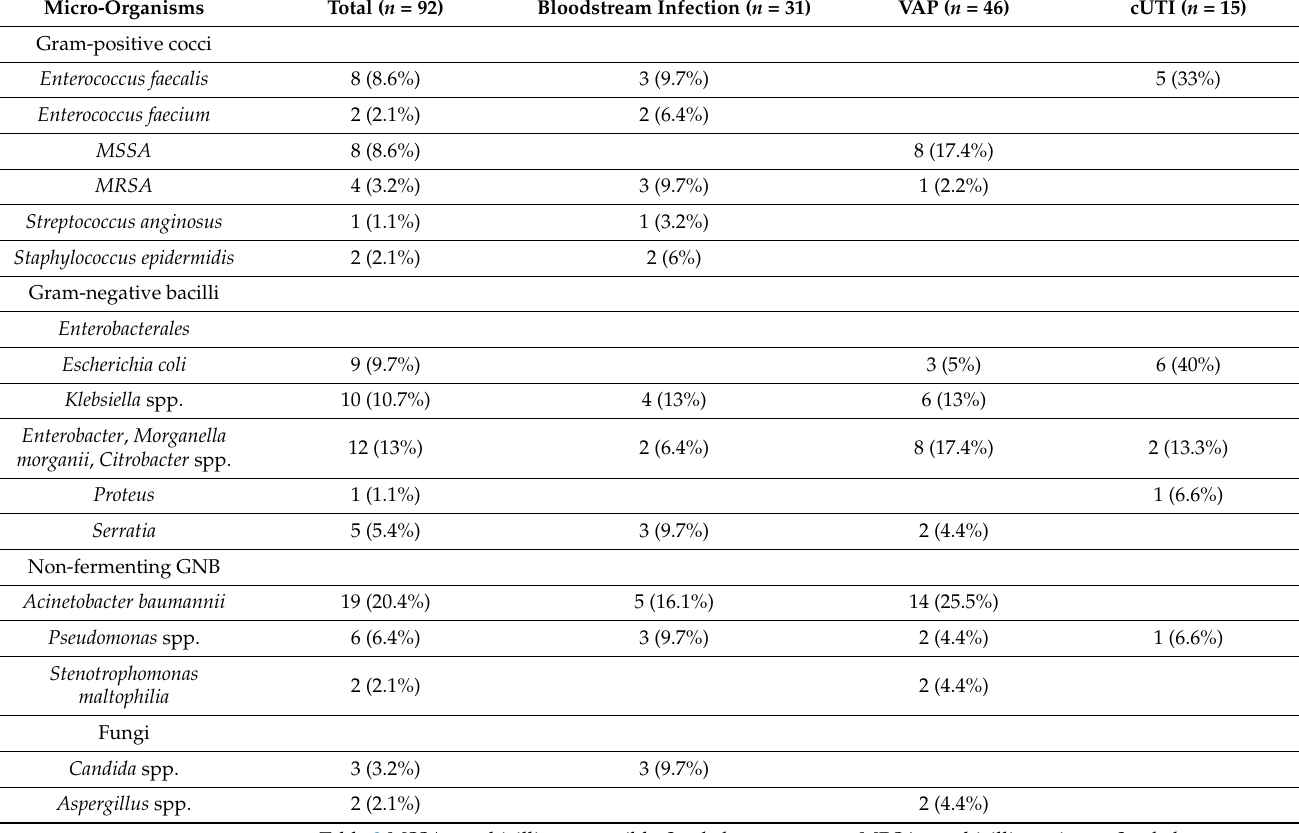
Table 3 MSSA: methicillin-susceptible Staphylococcus aureus ; MRSA: methicillin-resistant Staphylococcus aureus ; GNB: gram negative